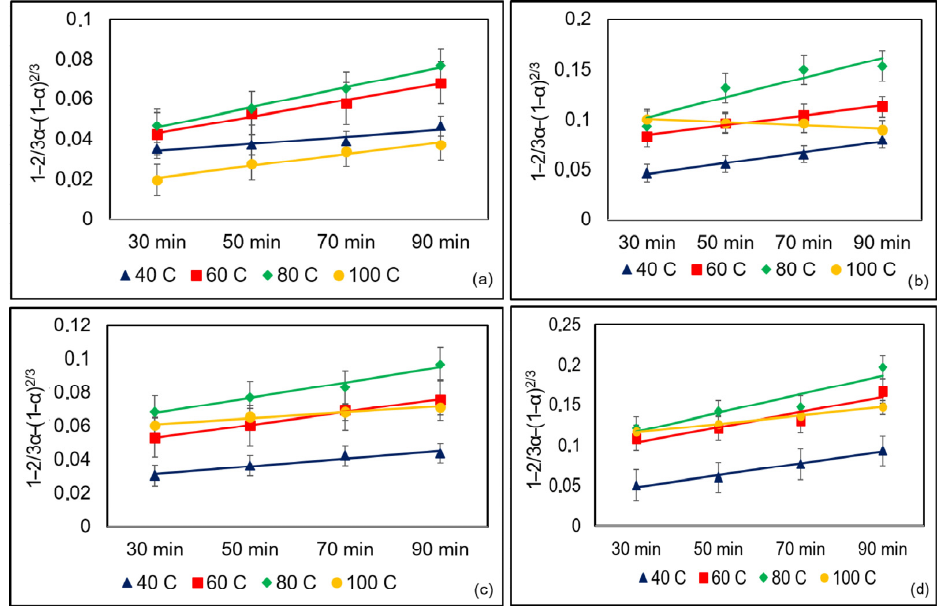
Figure 3. Plots of 1 − 2 α − ( 1 − α ) 3 vs. time at various conditions: ( a ) PS-CD/HA ratio = 1/1, pH = 1.92; ( b ) PS-CD/HA ratio = 1/2, pH = 1.92; ( c ) PS-CD/HA ratio = 1/1, pH = 1.5; ( d ) PS-CD/HA ratio = 1/2, pH = 1.5.